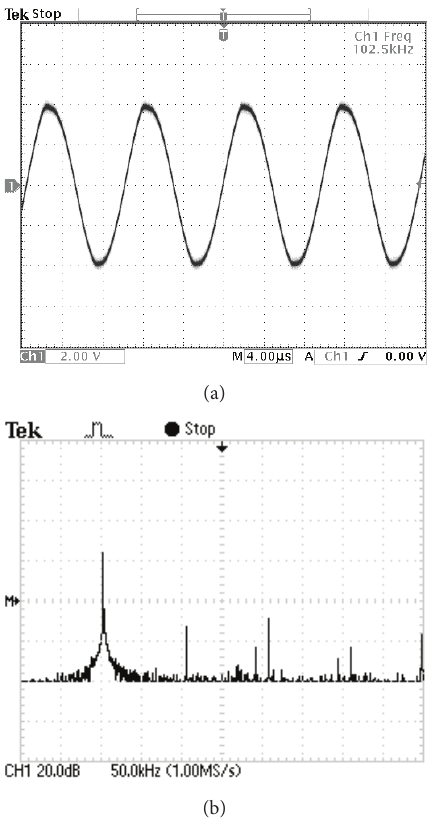
Figure 8: Experimental results for the circuit (Figure 4(c)): (a) output waveform and (b) corresponding frequency